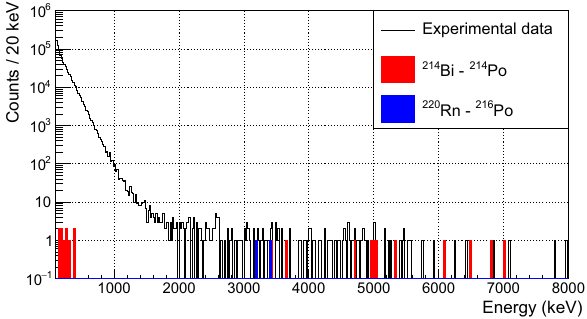
Fig. 7 Measured spectrum (black) and selection of 214 Bi– 214 Po (red) and 220 Rn– 216 Po (blue), belonging to the 238 U and 232 Th decay chains, respectively. The analysis of time correlations allows to disentangle the 238 U and 232 Th contamination in the continuum produced by energy- degraded α s